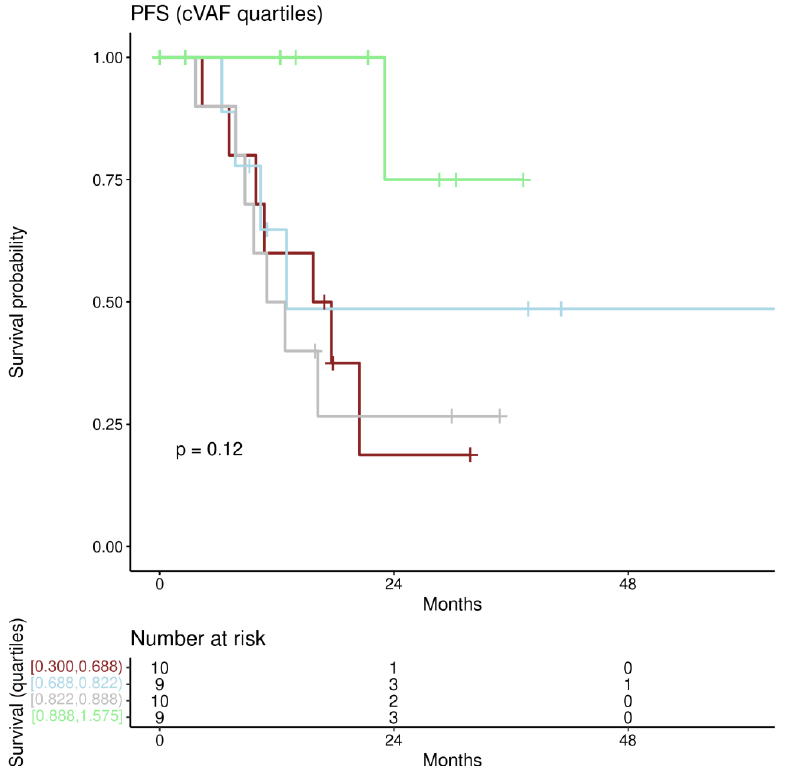
Figure 2. PFS for cVAF quartiles: Kaplan–Meier estimates for PFS categorizing cVAF along quartiles (Borders for cVAF are shown bottom left with “[” indicating including, and “)” indicating excluding). The lowest quartile is shown in brown, the second in blue, the third in grey, and the highest quartile in green. To determine the optimal cut-off of cVAF for PFS, the cutp function from R-package MASS was used, yielding 0.874 as the optimal cut-off with the lowest hazard ratio (HR)